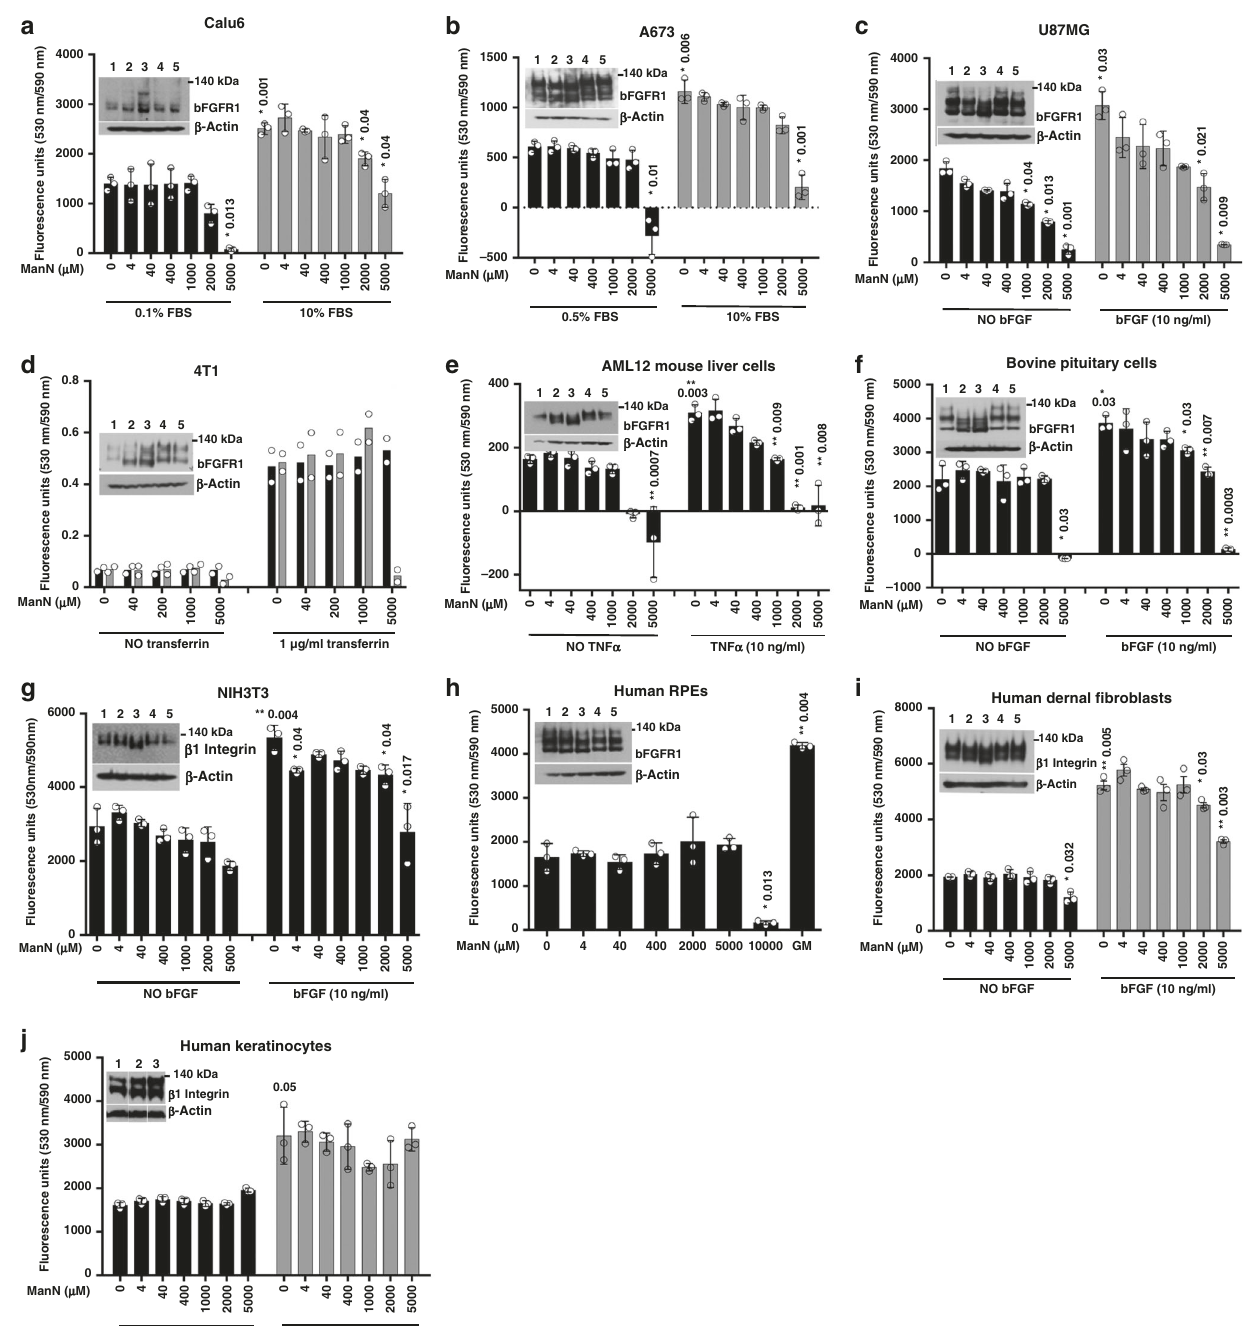
Fig. 6 Effects of ManN on non-ECs. Effects of ManN on non-endothelial cells of bovine, mouse, or human origin. ManN did not promote growth of Calu6 ( a ), A673 ( b ), U87MG ( c ), and 4T1 ( d ) tumor cells. Ten-percent FBS was used as positive control for Calu6 and A673, whereas 10 ng/ml bFGF and 1 μ g/ ml human apo-transferrin were used as positive controls for U87MG and 4T1, respectively. Similarly, no increases in proliferation were induced by ManN on AML12 ( e ), bovine pituitary cells ( f ), NIH3T3 cells ( g ), human RPEs ( h ), human dermal fi broblasts ( i ), and human keratinocytes ( j ), alone or in combination with growth factors. Proliferation quanti fi cation was performed using AlamarBlue ® or MTS (for 4T1 cells). n = 3 independent samples. Inserted are representative western blot analyses showing dose-dependent effects of ManN and mannose at 400 μ M (2,4) and 2 mM (3,5) on bFGFR1 or β 1 integrin (for 4T1, AML12, NIH3T3 cells, human skeletal muscle cells, human dermal fi broblasts, and human keratinocytes) molecular mass compared